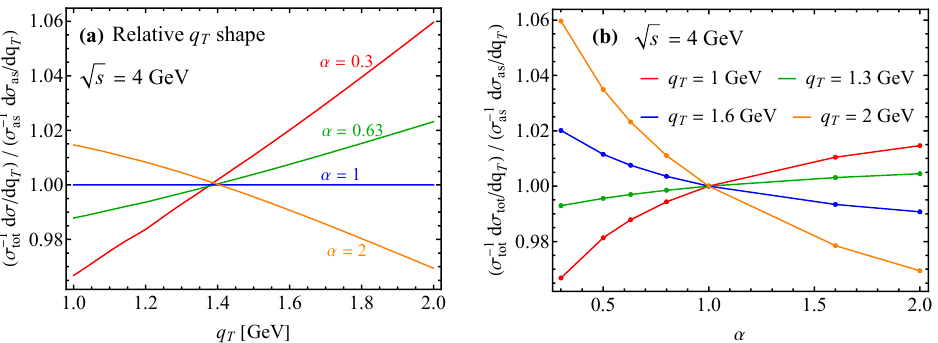
Figure 21. (a) The relative q T shape for a few choices of power-form DAs with different values of α . The relative q T shape is obtained by dividing the normalized q T distribution by the one with the asymptotic DA form. (b) The same normalized q T distribution as a function of α of the power-form